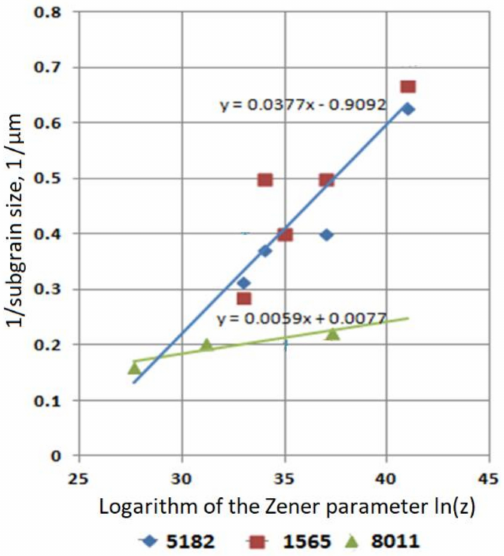
Figure 17. Dependence of the subgrain size on the Zener–Hollomon parameter for different alloys. δ − m is subgrain size, ss Z is Zener–Hollomon parameter, m , A , B are evidence-based